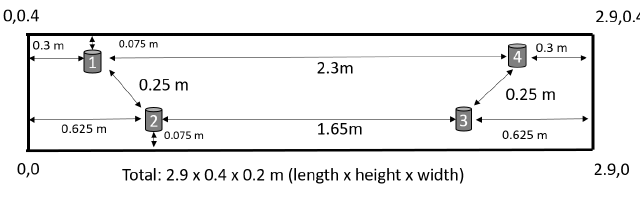
Figure 5. Ultrasonic sensor